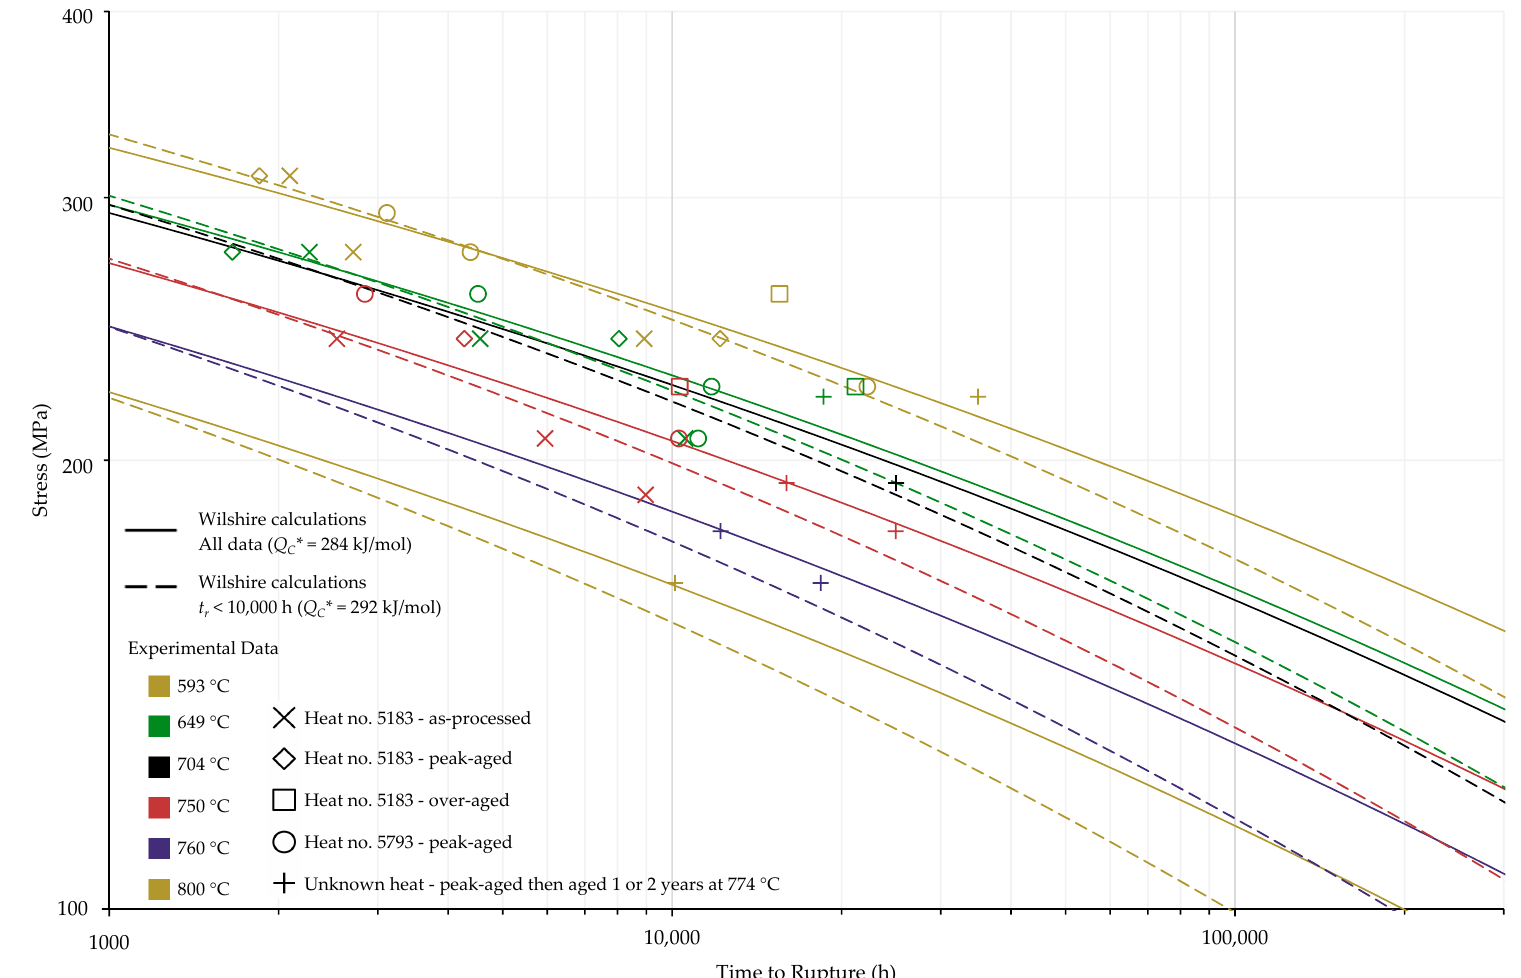
Figure 5. Calculations of the Wilshire equation with the lowest error for Nimonic 105 using averaged tensile strength values.